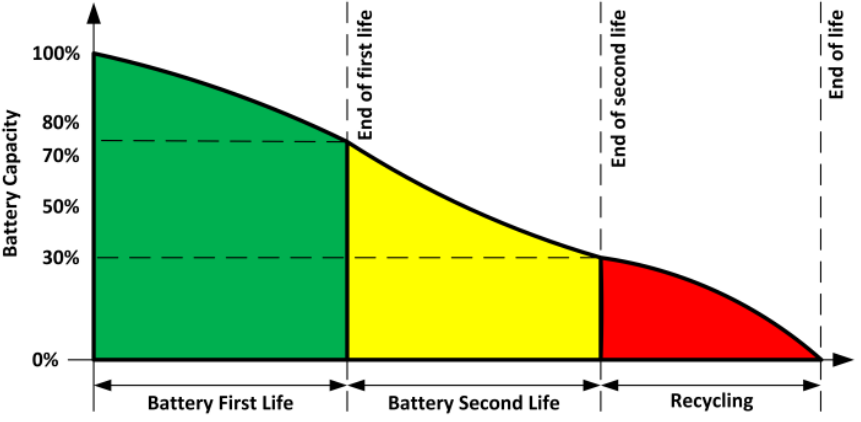
Figure 2. Plot of EV battery life range as a function of battery capacity.